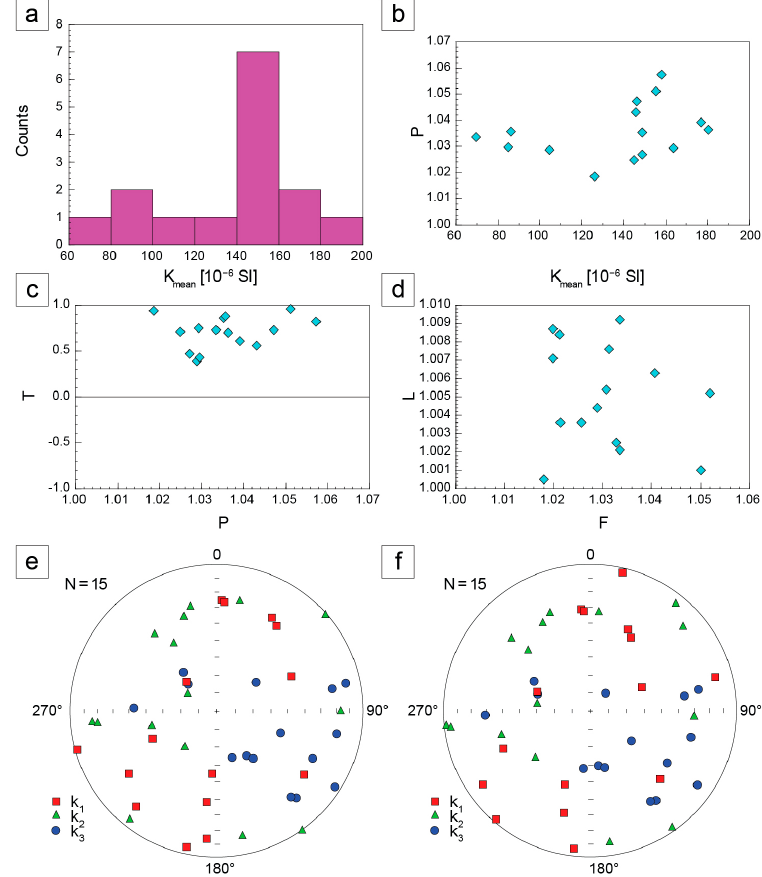
Figure 9. Anisotropy of Magnetic Susceptibility (AMS) of selected samples from the whale-bearing layer in section H (see Figure 3 for stratigraphic position). ( a ) Histogram of k mean . ( b ) Scatterplot of shape parameter P to K mean suggesting there is no correlation between AMS shape and susceptibility intensity. ( c ) Jelinek and ( d ) Flinn scatterplots highlighting the prolate nature of AMS ellipsoids. ( e ) In situ and ( f ) tilt-corrected equal area projection of poles of k 1 , k 2 and k 3 susceptibility axes.